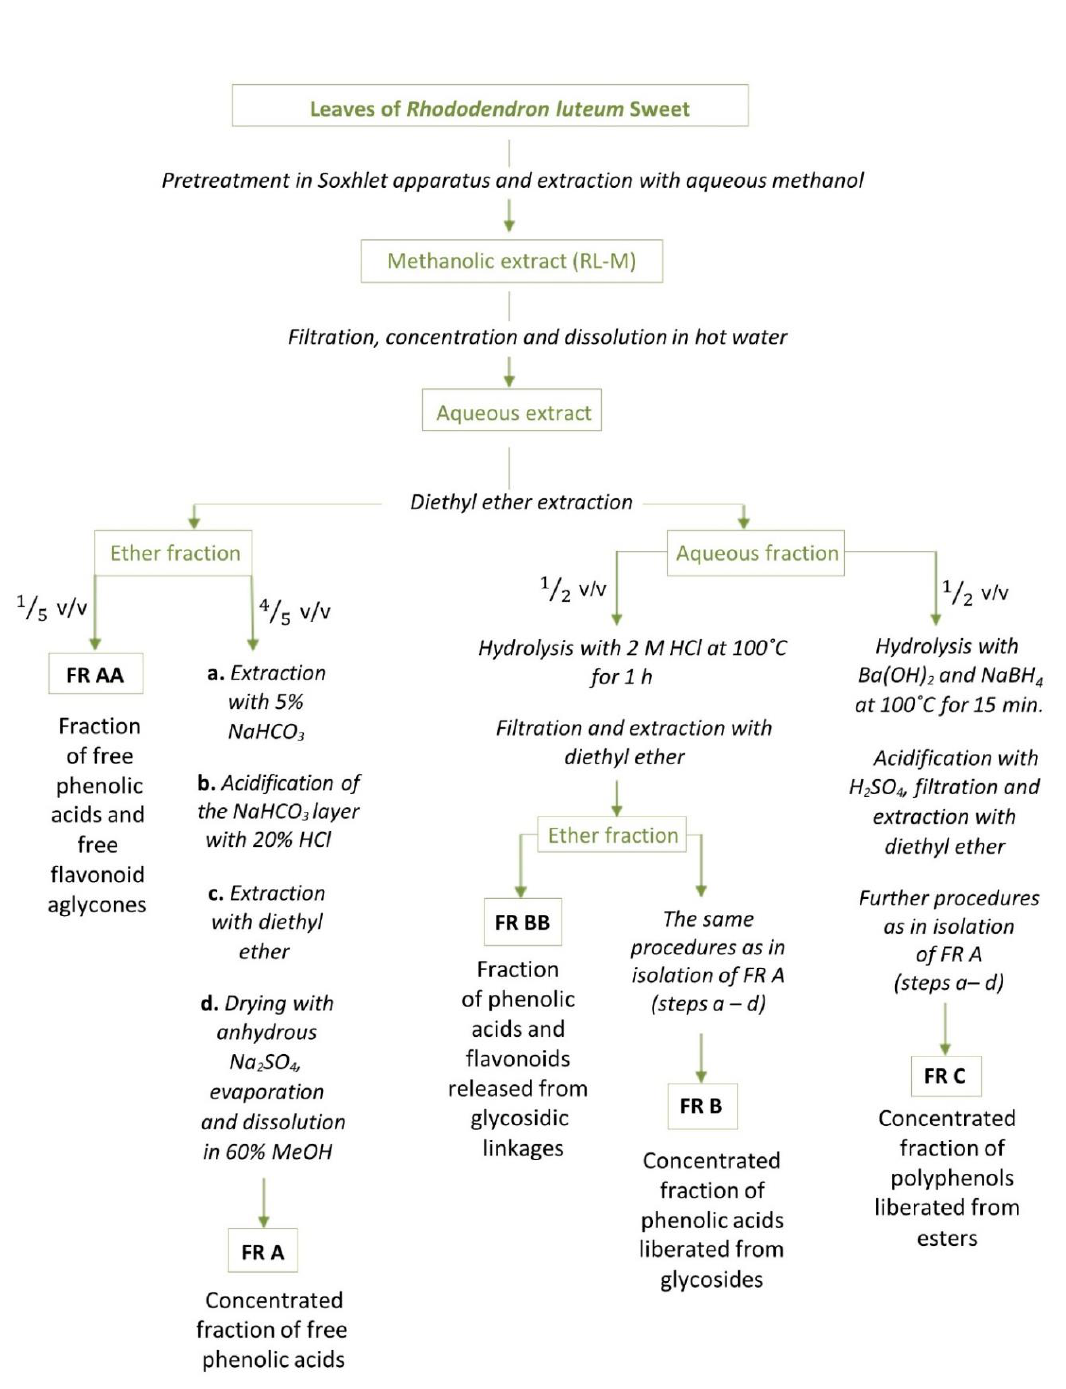
Figure 2. General scheme of the sample preparation procedures.